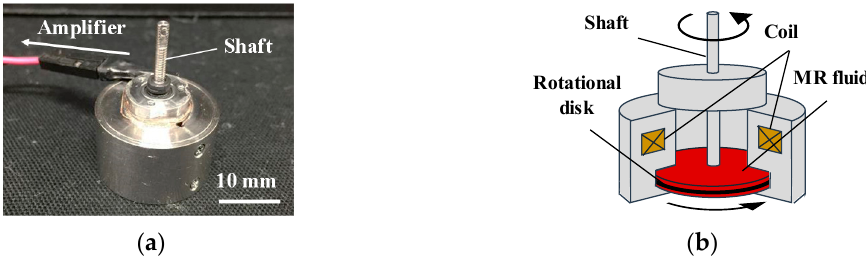
Figure 1. Haptic device and haptic display system: ( a ) photograph of the haptic device and ( b ) schema of the device.